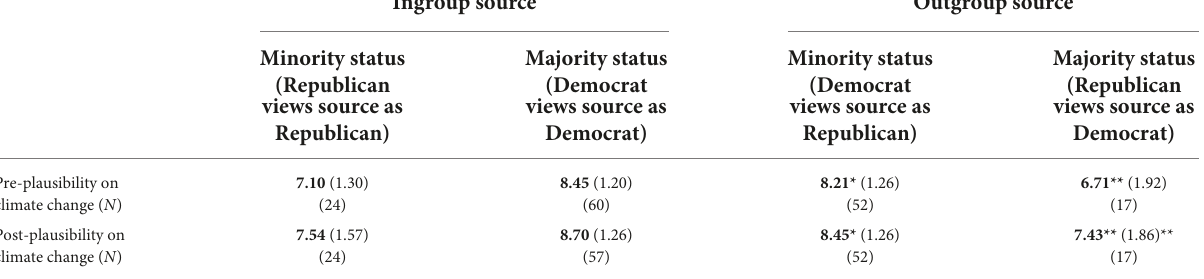
TABLE 4 Score means for plausibility perceptions of climate